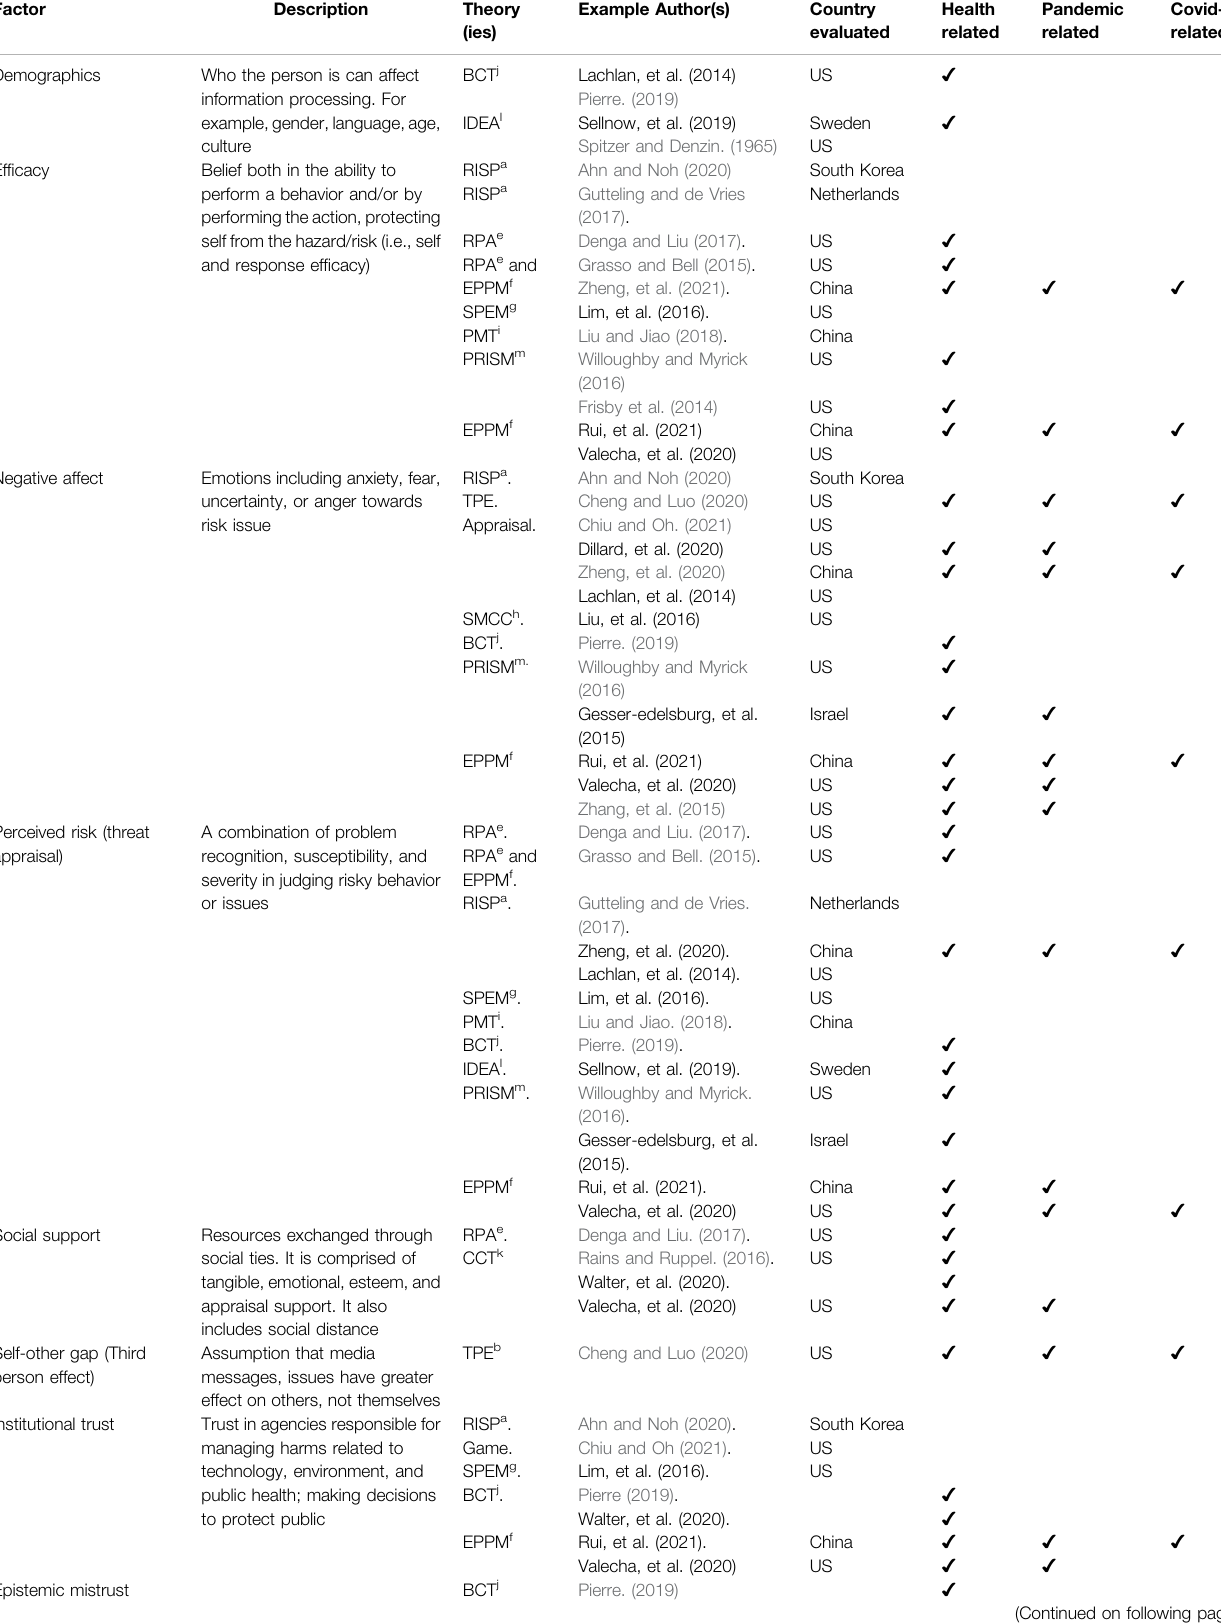
TABLE 1 | Factors in fl uencing information seeking and information evaluation in self-protective